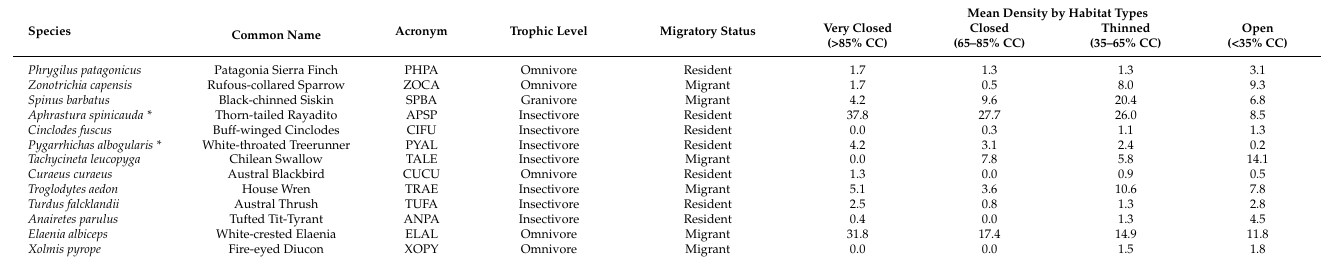
Table 2. Taxonomy, acronym, trophic level, migratory status, and mean density (ind ha − 1 ) by habitat types for the bird species analyzed in Nothofagus antarctica forests of Tierra del Fuego, Argentina.